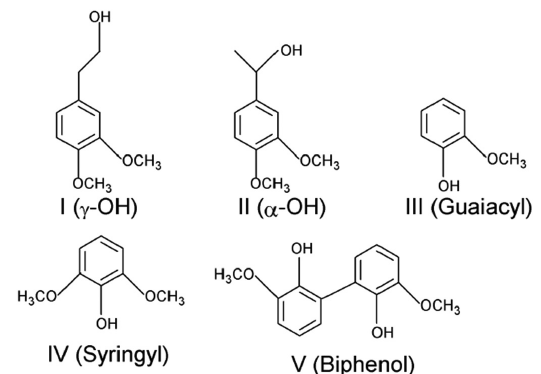
Figure 1. Chemical structure of several lignin